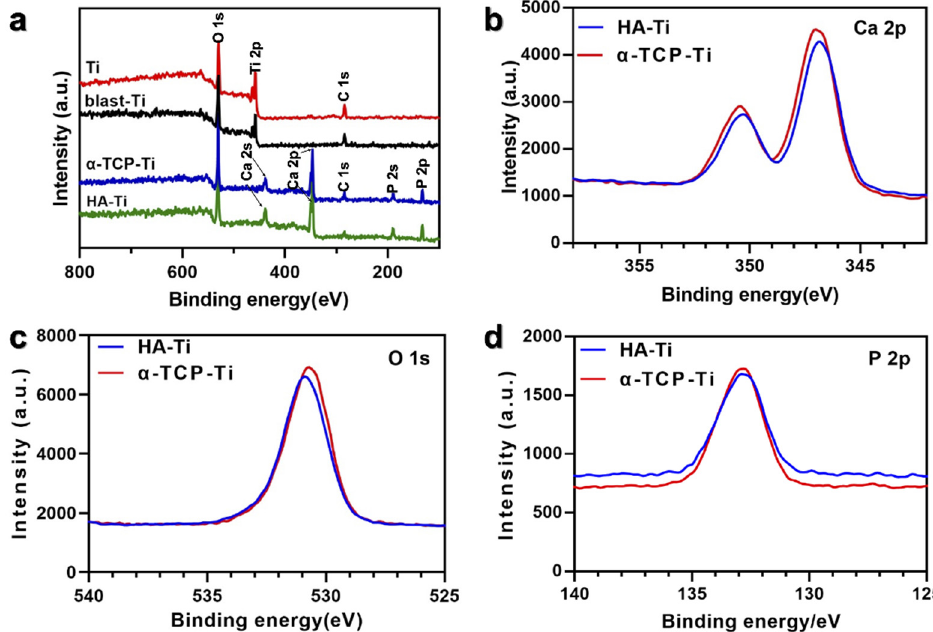
Figure 6. X-ray photoelectron spectra (XPS) of Ti, blast-Ti, α -TCP-Ti, and HA-Ti discs: ( a ) Wide-scan XPS of the material surfaces. ( b ) High-resolution spectra of Ca 2p. ( c ) High-resolution spectra of O 1s. ( d ) High-resolution spectra of P 2p.